Question: What style of plot is this figure drawn as?
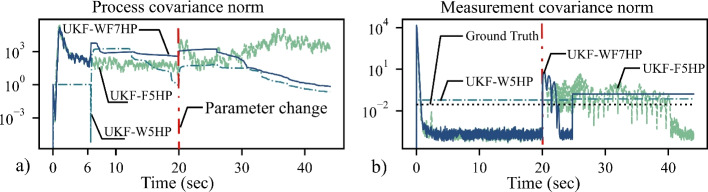
Answer: line